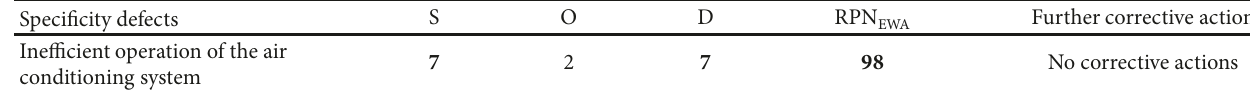
Table 8: Results after second FMEA analysis of the engine with attachments